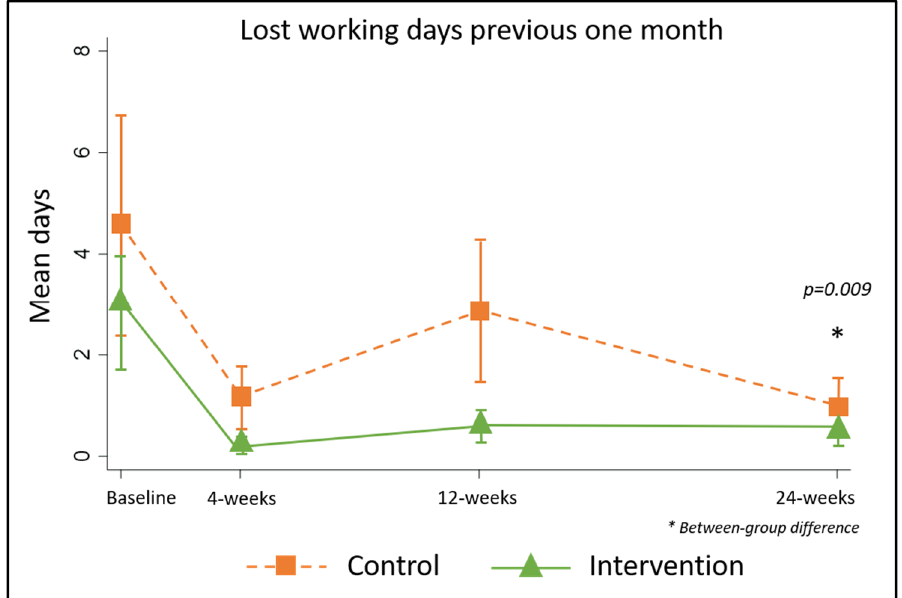
Figure 10. Number of lost working days by group.